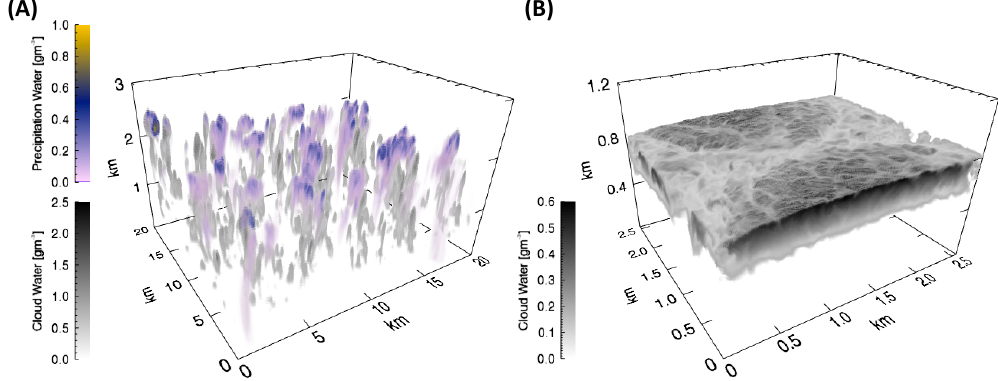
Figure 2. Three-dimensional rendering of the LES time steps analyzed in this work for RICO (a) and DYCOMS-II RFO1 (b) . Gray scale shows cloud water content, while color scale shows precipitation water. No precipitation is present in the DYCOMS simulation.